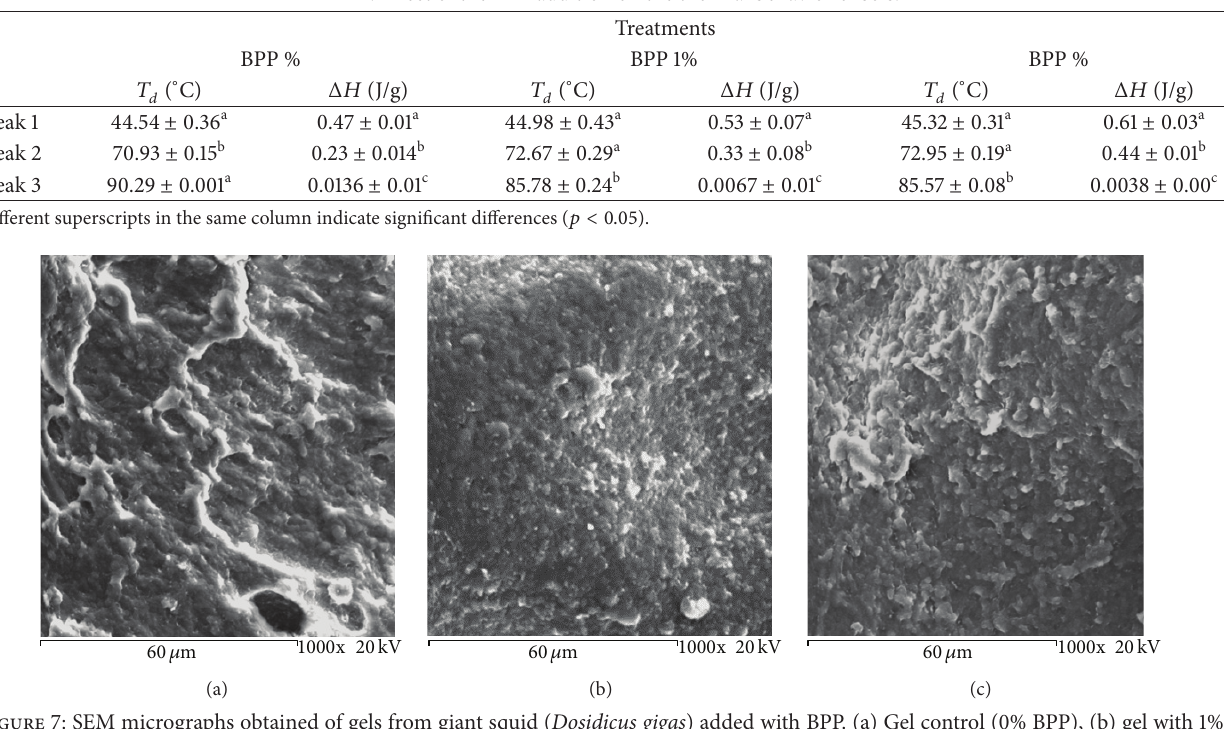
Table 2: Effect of the BPP addition on the thermal behavior of sols.